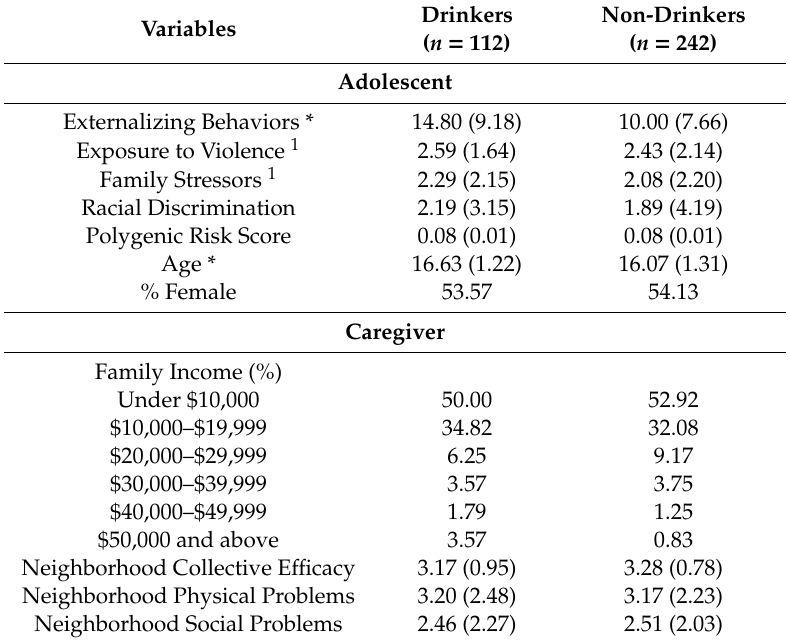
Table 1. Comparison of African American youth reporting drinking and never drinking